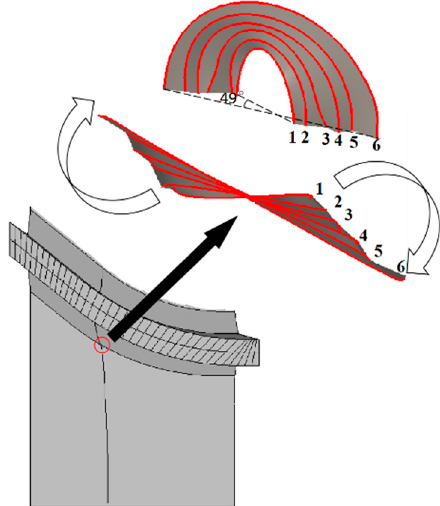
Figure 10. Crack kink in the early stage of the propagation.